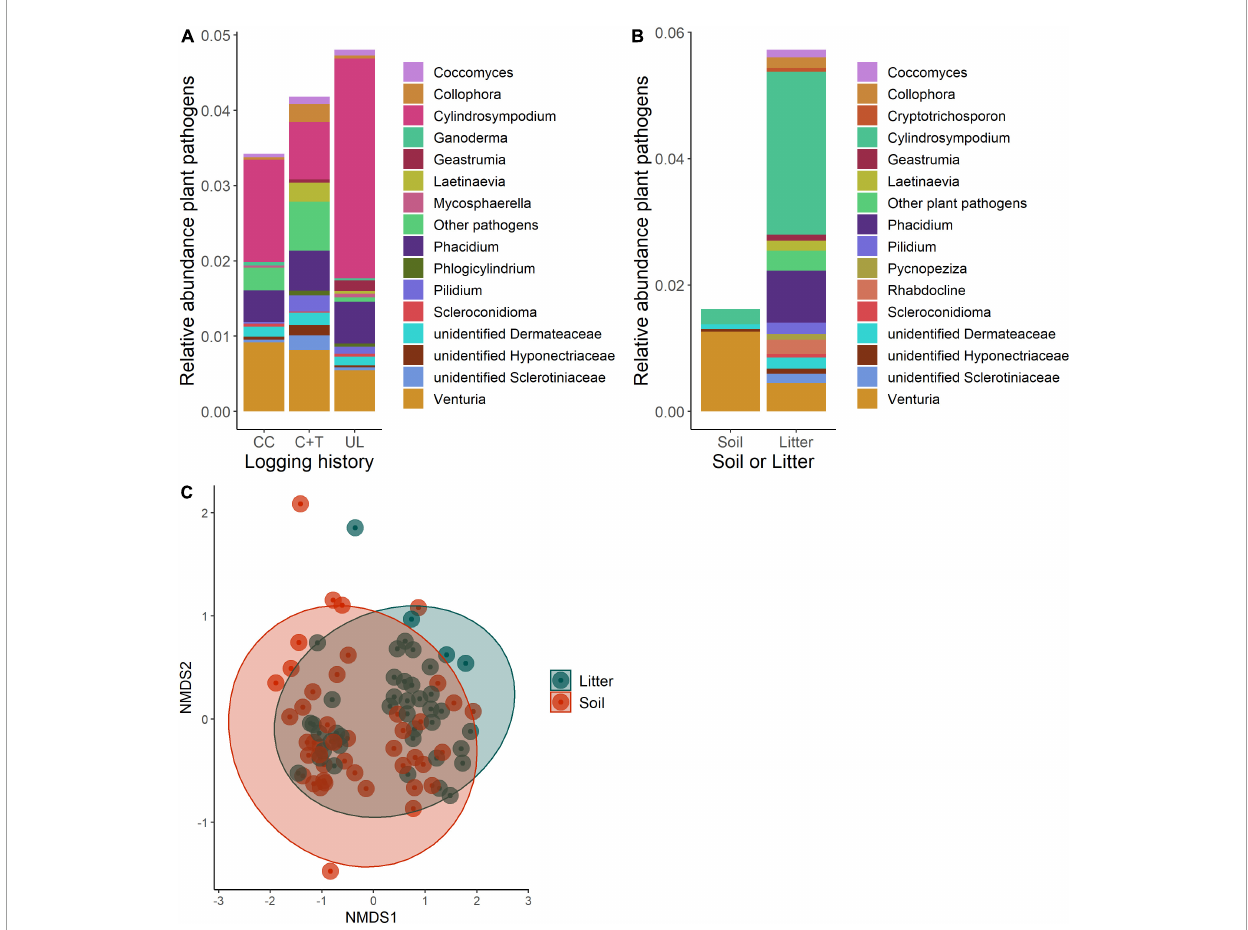
FIGURE5 Comparisons of pathogen communities in soil and litter of logged and unlogged forest stands within the H. J. Andrews Forest, Oregon, USA. Clearcut (CC), watershed 6, canopy + thinned (C + T), watershed 7, unlogged (UL), watershed 8. (A) Relative abundances of pathogen genera between watersheds. (B) Relative abundances of pathogen genera between soil and litter. (C) NMDS ordination of pathogen communities based on Bray-Curtis dissimilarities between soil and litter (PERMANOVA, p =